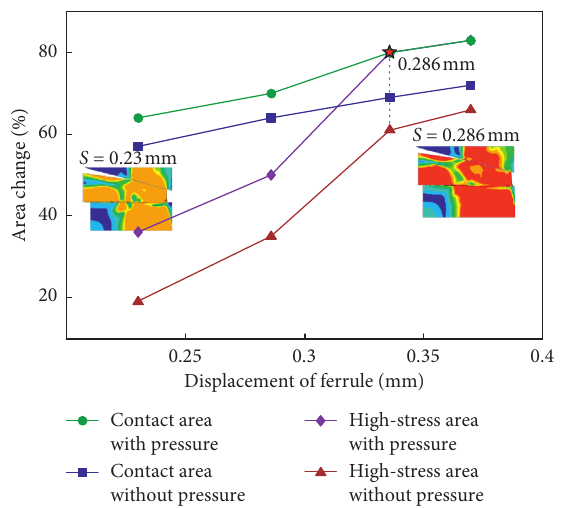
Figure 11: Contact area and high-stress area under different as- sembly